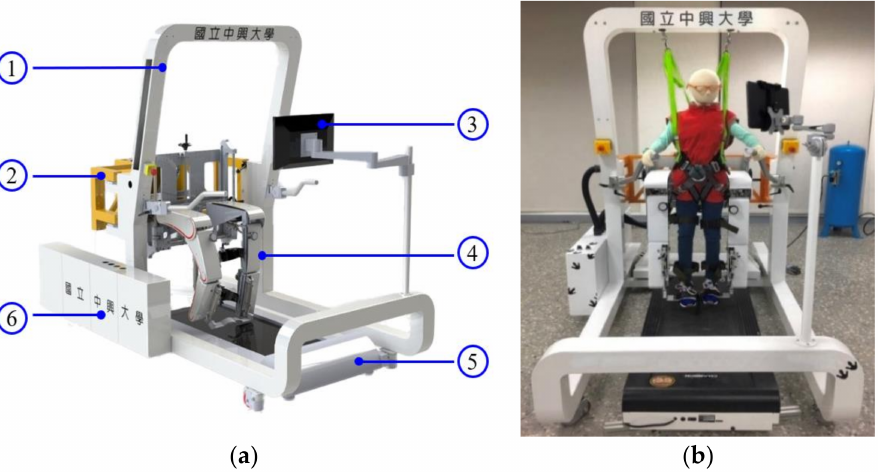
Figure 1. Prototype of the PRPGTS. ( a ) illustrates the prototype of the PRPGTS; ( b ) photo of the PRPGTS. 1 (cid:13) PBWSS, 2 (cid:13) pneumatic postural support system, 3 (cid:13) human–machine interface, 4 (cid:13) PGO, 5 (cid:13) treadmill, 6 (cid:13) embedded